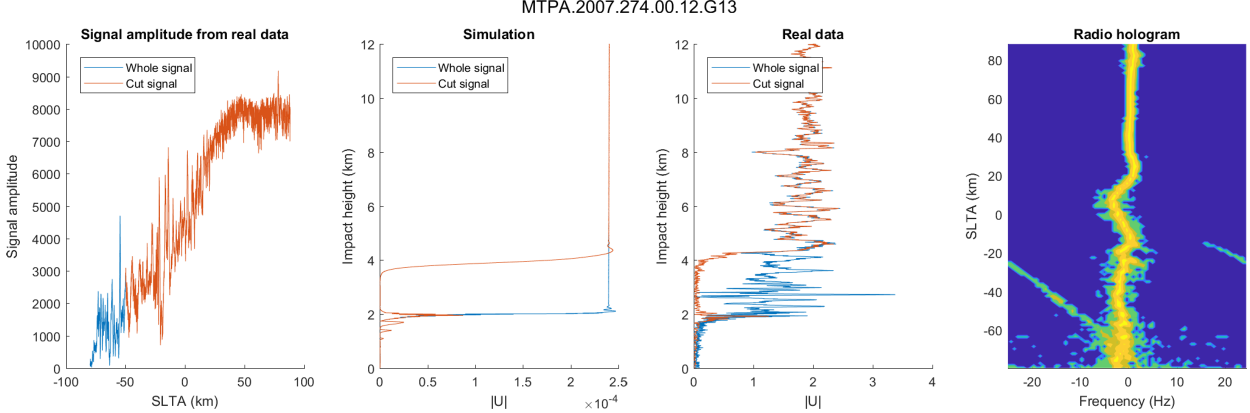
Figure 3. An event classified as category 1. SLTA min is at approximately − 73km, and the signal is truncated at SLTA = − 50km. The reflection spike is located at an impact height of 1919m, and a min is located at an impact height of 2017m.